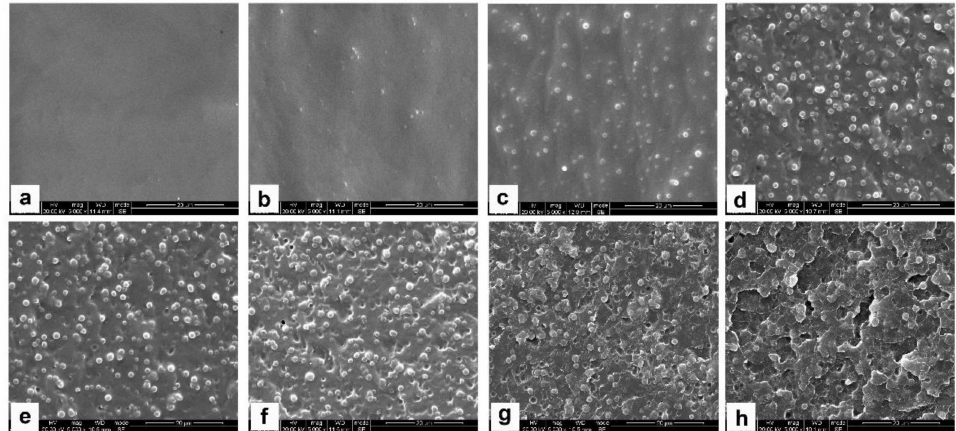
Figure 5. Morphological evolution process of MOEA-BOZ/DGEBA-ER/IMZ (12 wt%) blend with 30 wt% of ER at different curing stages: ( a ) before curing; after curing at ( b ) 110 ◦ C/15 min; ( c ) 110 ◦ C/65 min; ( d ) 110 ◦ C/6 h; ( e ) 110 ◦ C/11 h; ( f ) 110 ◦ C/24 h + 130 ◦ C/2 h + 150 ◦ C/2 h; ( g ) 110 ◦ C/24 h + 130 ◦ C/2 h + 150 ◦ C/2 h + 180 ◦ C/2 h; ( h ) 110 ◦ C/24 h + 130 ◦ C/2 h + 150 ◦ C/2 h + 180 ◦ C/2 h + 200 ◦ C/2